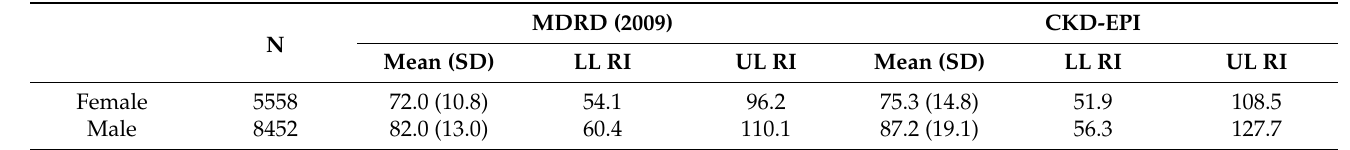
Table 2. eGFR estimation in females and males using MDRD (2009) and CKD-EPI formulas.